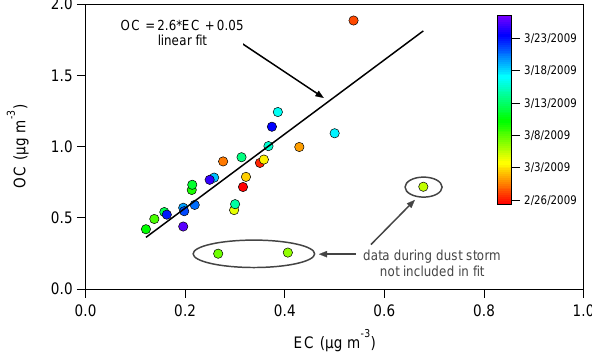
Fig. 3. Correlation of organic carbon (OC) and elemental carbon (EC) measured during the campaign for PM 1 . Data points are col- ored by time during the campaign. The OC:EC ratio during the dust storm period was lower than during the rest of the campaign, and these points were not included in the linear fit. Overall, the OC:EC ratio was much lower than during the summer, consistent with less photochemical